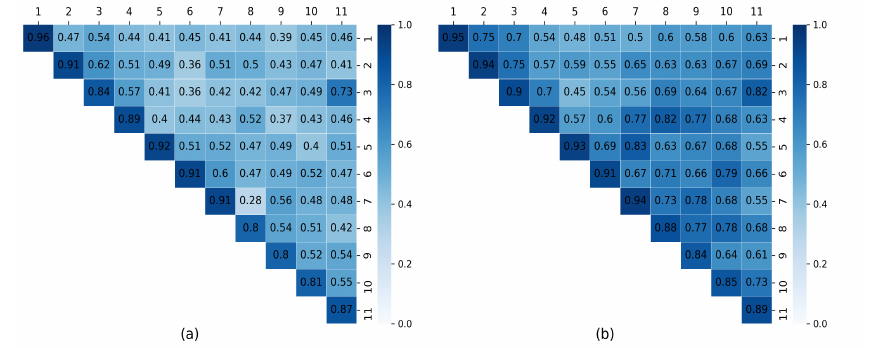
Figure 8. Heatmaps of cosine similarity of all classes using the CNN model on the PAMAP2 testing dataset: ( a ) softmax loss; and ( b ) additive angular margin